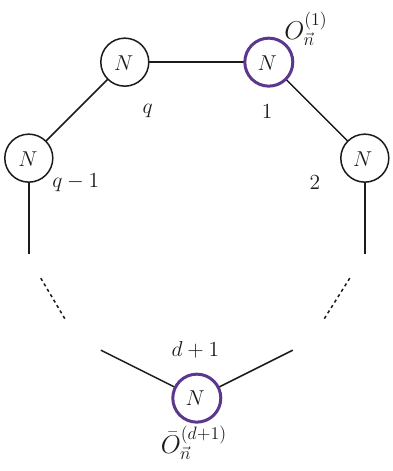
Figure 6. Insertion of operators O (1)